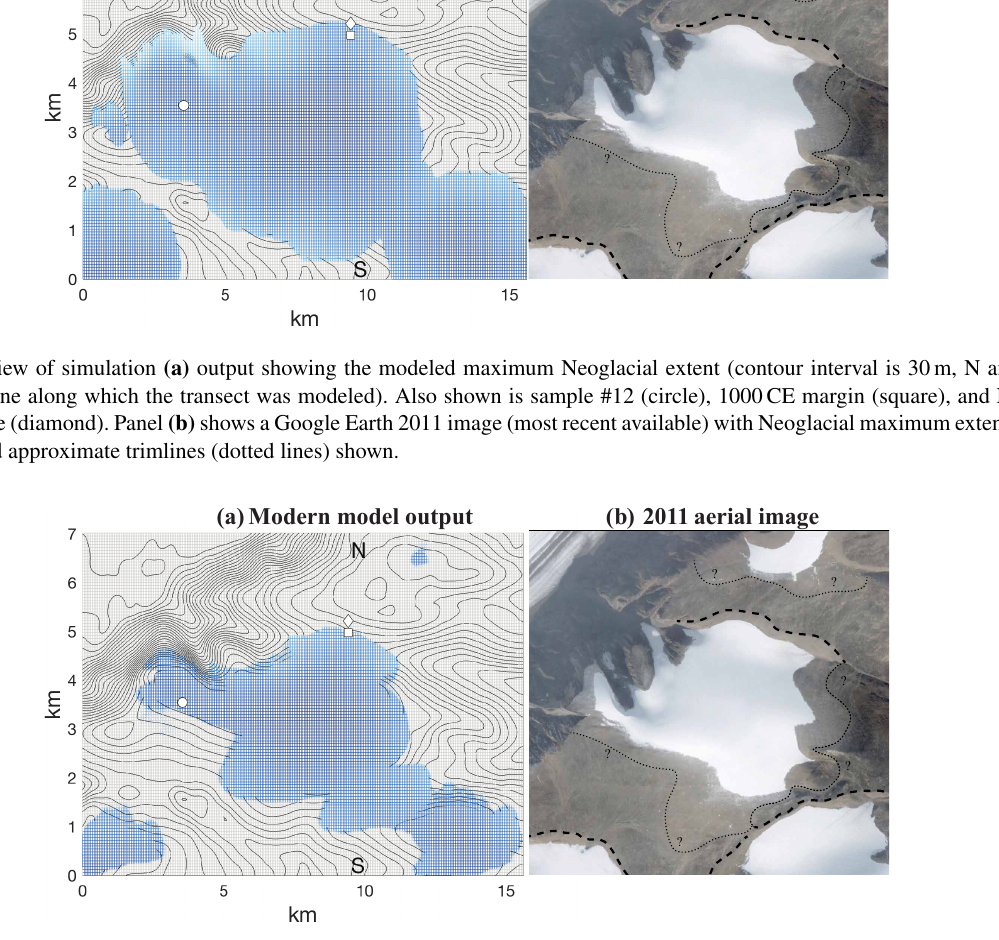
Figure 5. (a) Final output from the full simulation model showing the modeled modern (2015CE) extent of the ice cap following the advance and retreat scenarios outlined in text. Panel (b) shows a Google Earth 2011 image with Neoglacial maximum extent trimlines (dashed lines) and approximate trimlines (dotted lines) shown. Note similarities between model output and satellite imagery along the northern margin, but disagreements in other areas (east and